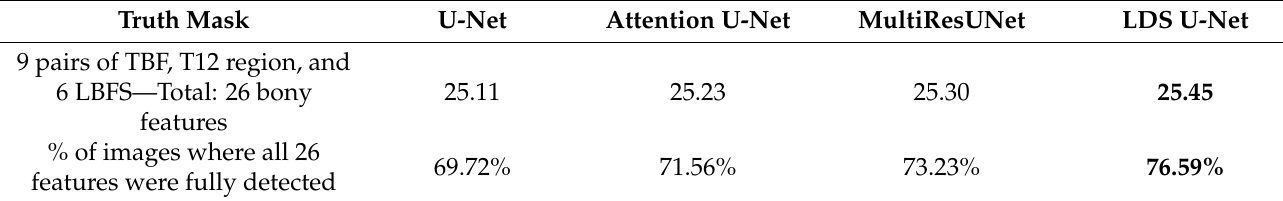
Table 3. Comparison between number of bony features identified (avg).